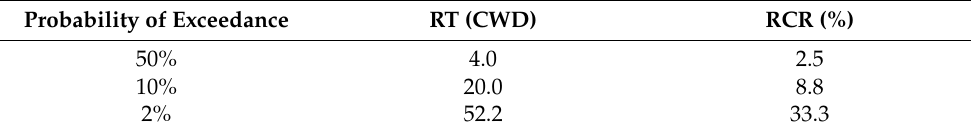
Table 3. Repair Time and total Repair Cost Ratio values for several probability of exceedance. Probability of Exceedance